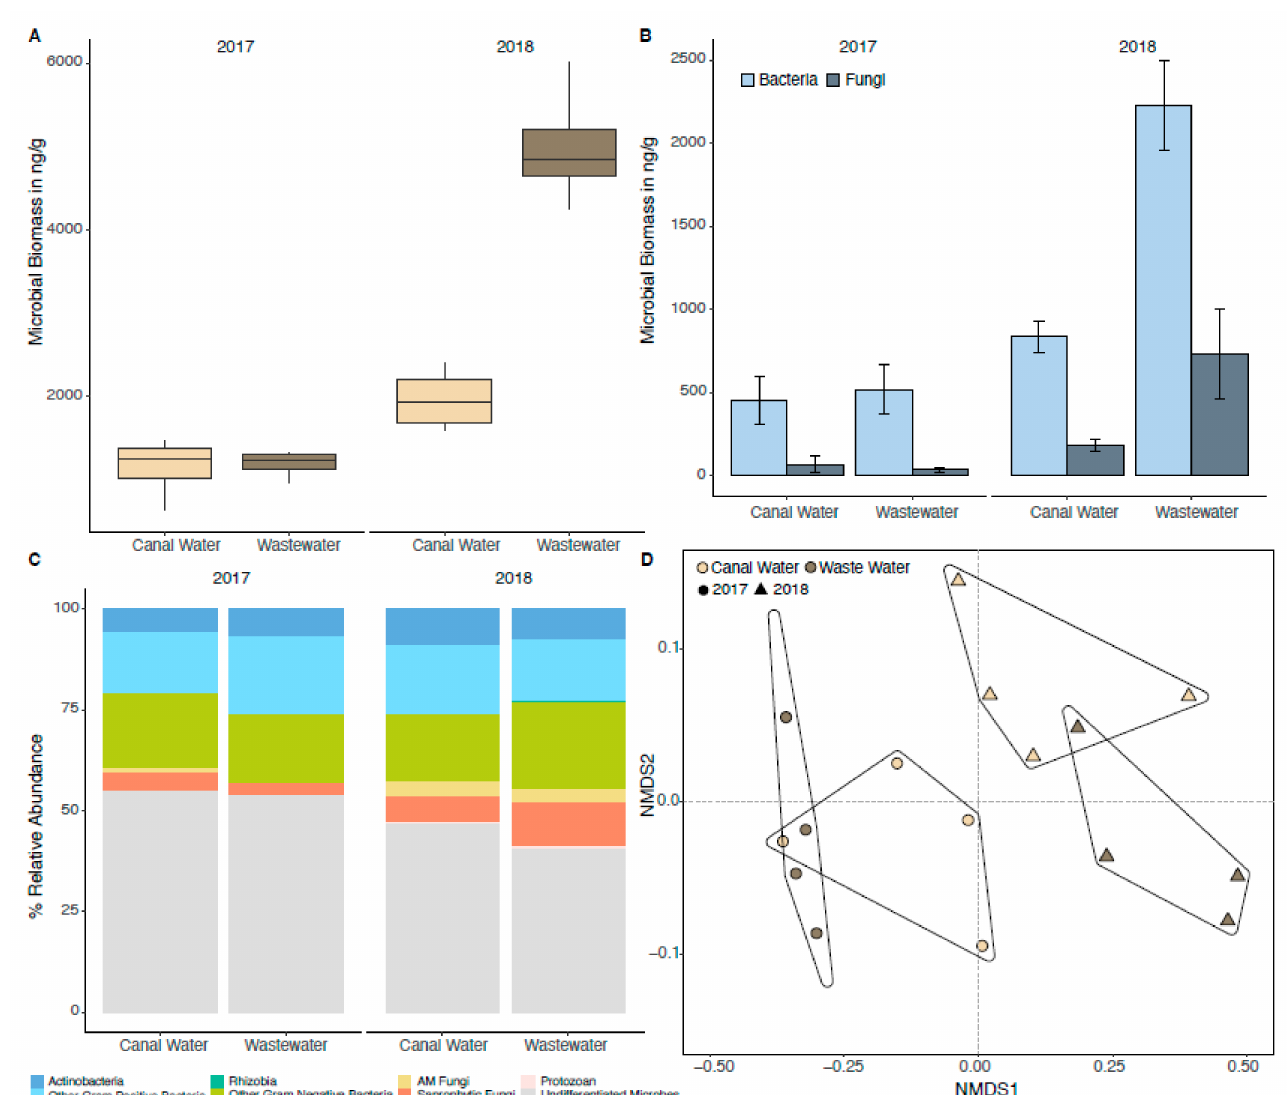
Figure 2. Soil microbial characteristics before and one year after alfalfa establishment when irrigated with surface water or treated municipal wastewater (Class 1B, UV-irradiated) at Tucumcari, NM, USA. ( A ) Total microbial biomass; ( B ) microbial biomass comparing bacteria and fungi; ( C ) relative abundance of microbial phospholipid fatty acid (PLFA) groups; ( D ) nonmetric multi-dimensional scaling (NMDS) ordination plot of the PLFA